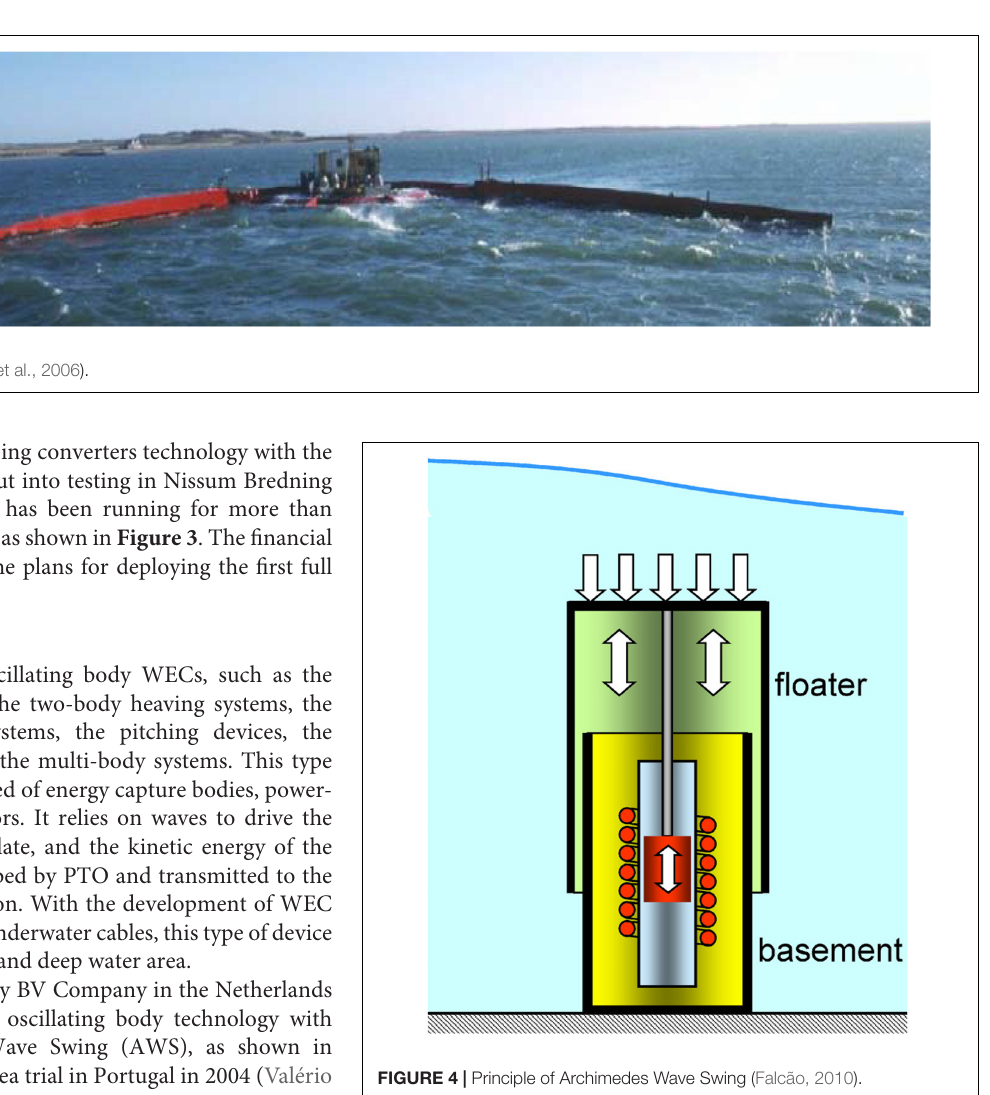
FIGURE 4 | Principle of Archimedes Wave Swing (Falcão,